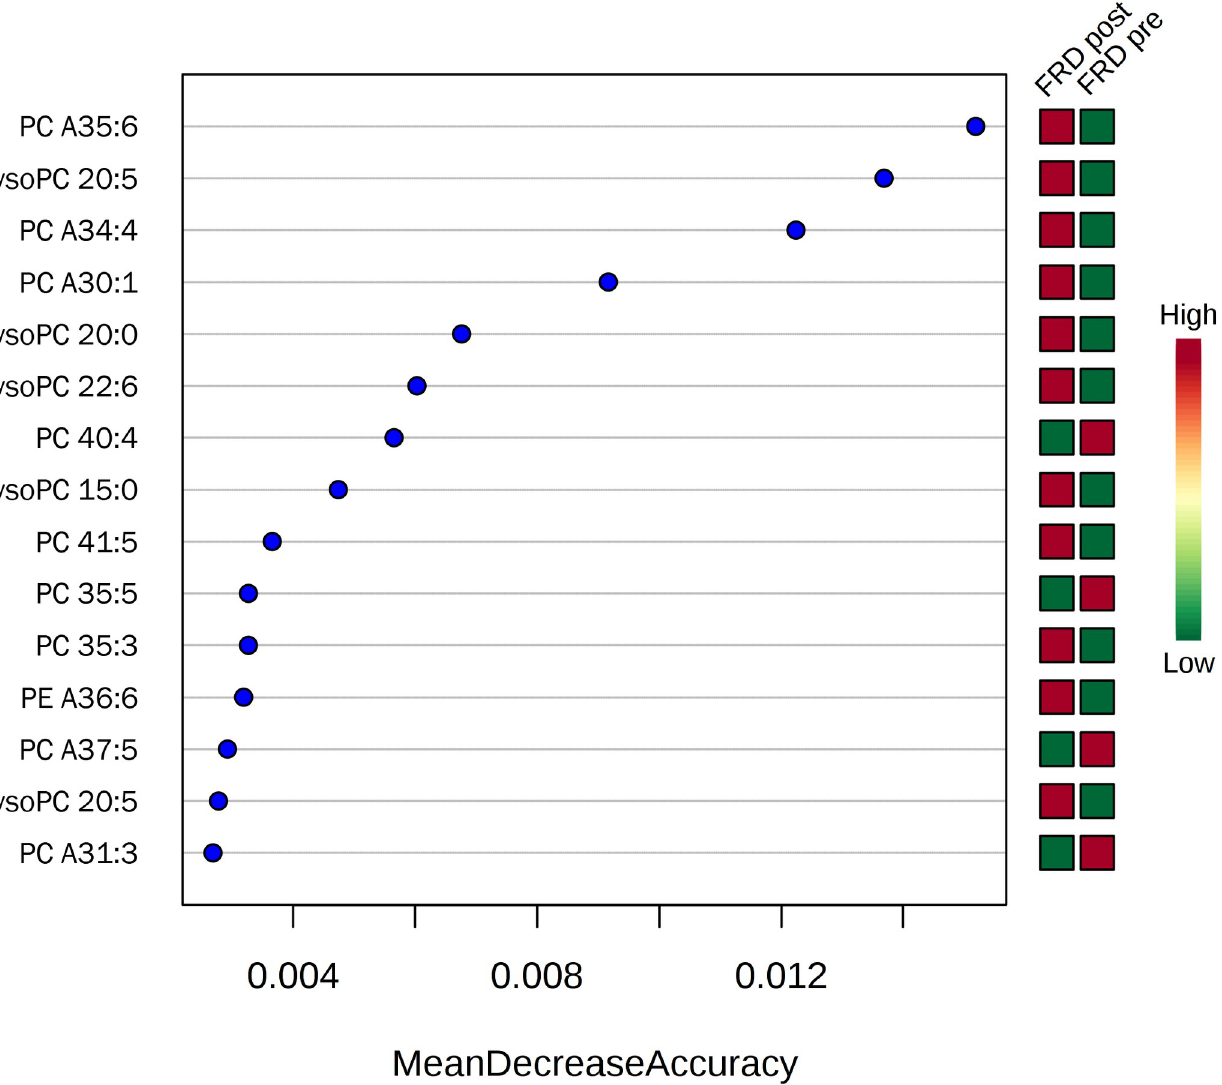
Fig 7. Random forest analysis of phospholipids and their association with treatment in FRD. The 15 top phospholipids based on their importance to discriminate between the treatment statuses of dogs with FRD are shown. Red boxes represent a high abundance, green boxes a low abundance of a given phospholipid. PC, phosphatidylcholine; PE, phosphatidylethanolamine; ’A’ indicates an ether species; the XX:y notation specifies the total number of carbon atoms in the radyl chains (’XX’) followed by the number of unsaturation (’y’).